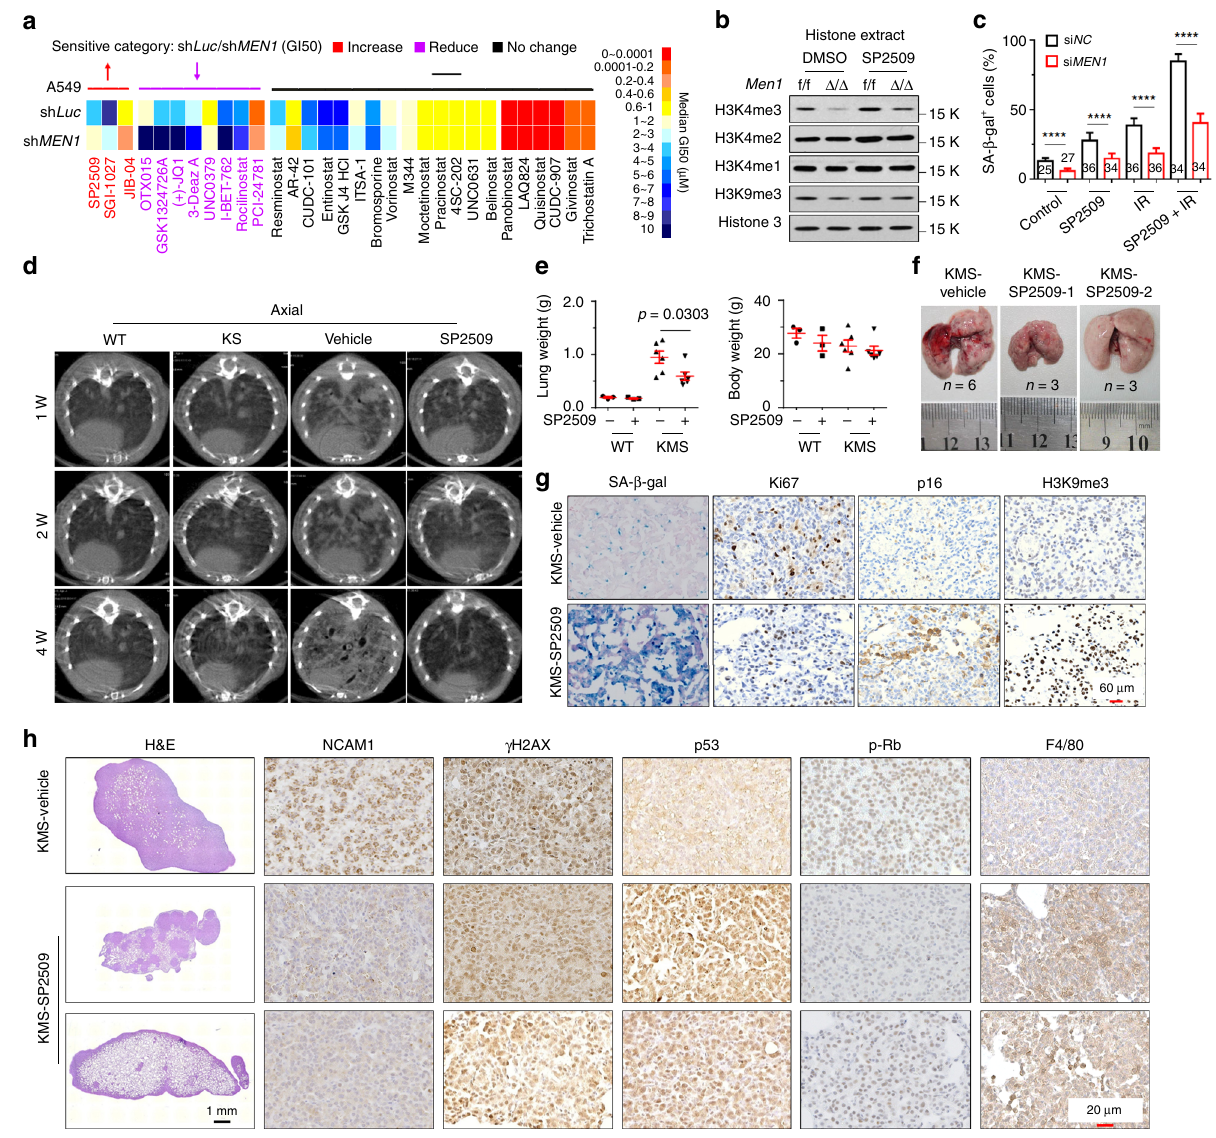
Fig. 7 An LSD1 inhibitor reverses NE differentiation. a Heatmap of median GI 50 values for A549-sh Luc and A549-sh MEN1 cells treated with 96 small molecule inhibitor compounds for 3 days. The results were ranked according to the difference in sensitivity between A549-sh Luc and A549-sh MEN1 cells as determined by the GI 50 ratios (GI 50 A549-sh Luc /A549-sh MEN1 ). b Men1 f/f and Men1 Δ / Δ MEF cells were treated with SP2509 for 24 h, and the levels of H3K4me3, H3K4me2, H3K4me1, and H3K9me3 modi fi cations in histone extracts were determined via western blotting. c Quanti fi cation of the SA- β -gal- positive IMR-90 cells shown in Supplementary Fig. 7b. Cells were transfected with siRNA for 48 h and then treated with 1 μ M SP2509 for 4 h. SA- β -gal staining was performed 2 days after exposure to 5 Gy of IR. d Axial microCT images in the indicated planes from WT, KS, KMS, and SP2509-treated (25 mg/kg i.p. injection) KMS mice at 1, 2, and 4 weeks. e Quanti fi cation of lung and body weight for KMS-vehicle and SP2509-treated KMS mice at 51 days (WT con: n = 3; WT SP2509: n = 3; KMS con: n = 6; KMS SP2509: n = 6). f Bright fi eld images of lung tissue from KMS and SP2509-treated KMS mice at 51 days. g Representative images of SA- β -gal staining and IHC staining in consecutive lung sections from KMS-vehicle, and SP2509-treated KMS mice at 51 days. Scale bars, 60 μ m. h H&E images (left) and IHC staining for the indicated proteins in lung sections from KMS-vehicle and SP2509-treated KMS mice at 51 days ( n = 7 per group). Scale bars, 1 mm (H&E) and 20 μ m (IHC). Data are represented as mean ± SD in c and as mean ± SEM in e . Dots in e depict individual samples. Signi fi cance determined by Two-tailed unpaired t tests in c and e are indicated. **** p < 0.0001. Results in b are representative of three independent experiments. Source Data are provided as a Source Data fi